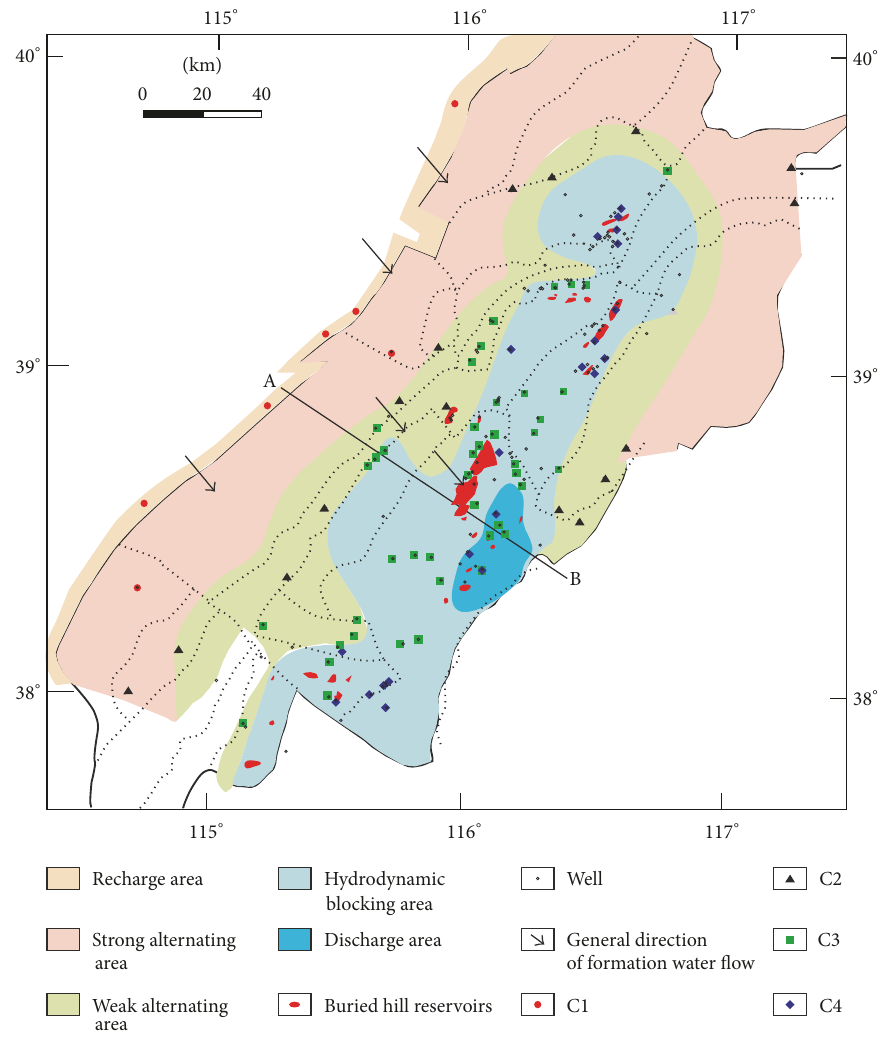
Figure 11: The analysis of hydrodynamic conditions in buried hill, Jizhong